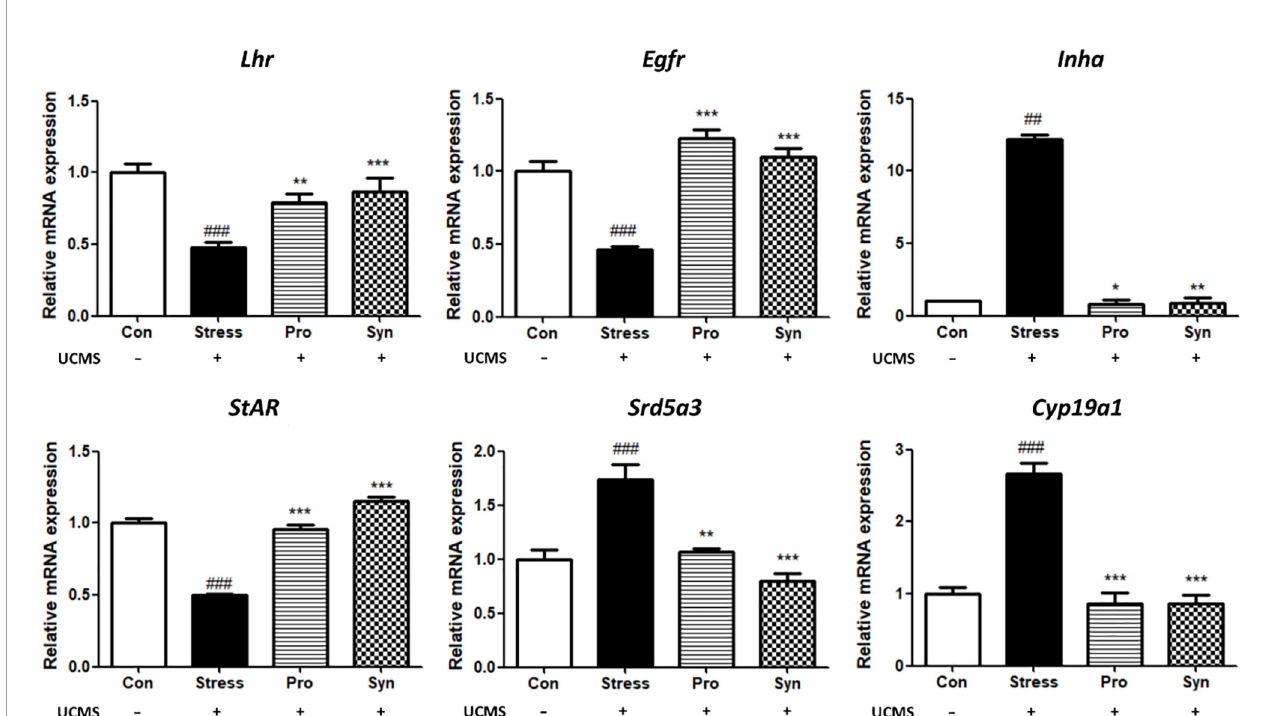
FIGURE 5 | Effects of probiotics and synbiotics treatments on the transcription of spermatogenesis and growth factor related genes in mice testes under UCMS. Data describes the relative expressions of Lhr , Egfr , Inha , StAR , Srd5a3 , and Cyp19a1 compared to Gapdh . Data represent the mean ± SEM (n=12) from three independent experiments. # Signi fi cant difference compared to the Con group ( # p < 0.05, ## p < 0.005, ### p < 0.001). *Signi fi cant difference compared to the Stress group (* p < 0.05, ** p < 0.005, *** p <